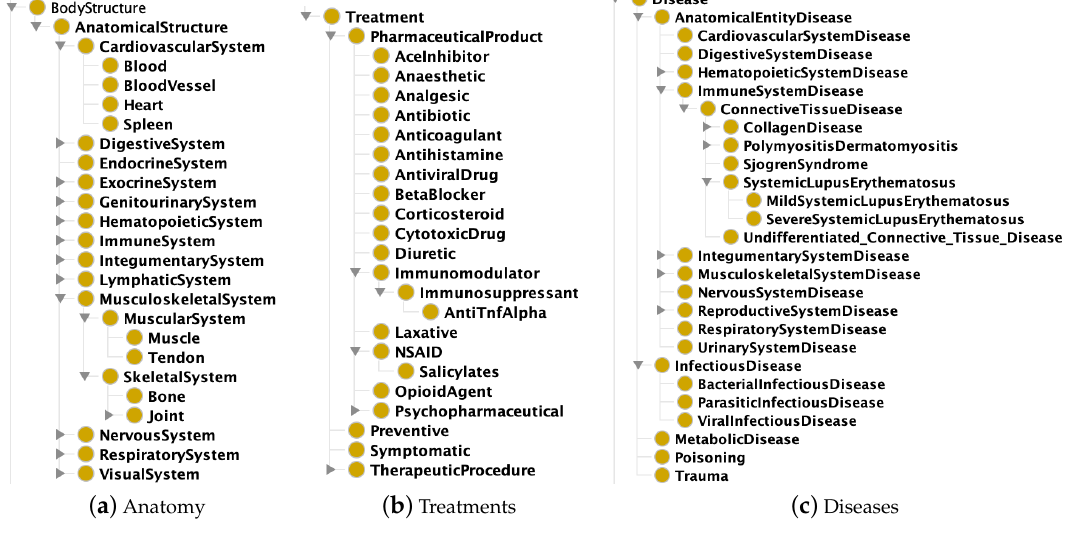
Figure 4. Conceptual model of the medical